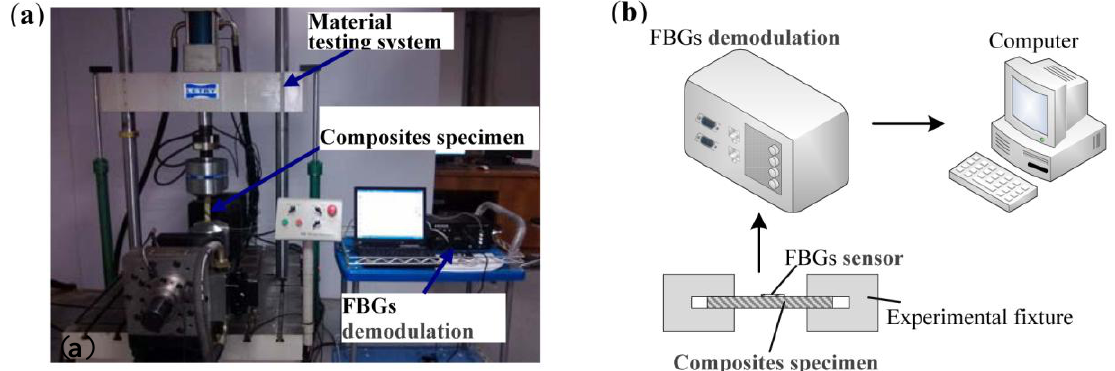
Figure 8. Experimental system of the FBGs strain test system: ( a ) Picture. ( b ) Schematic.